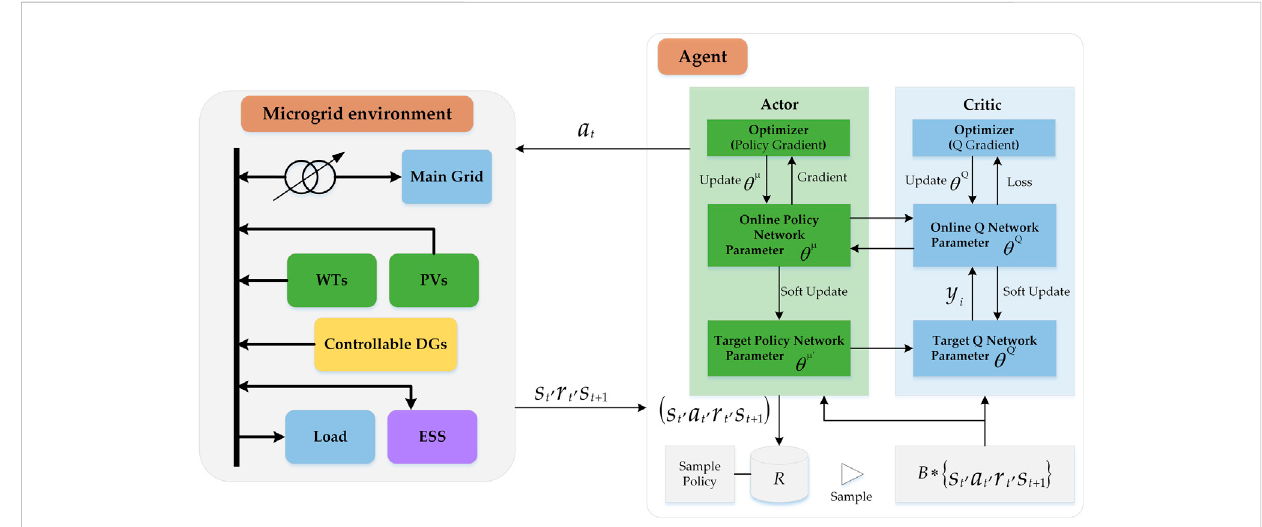
FIGURE 3 Structure of the proposed DDPG